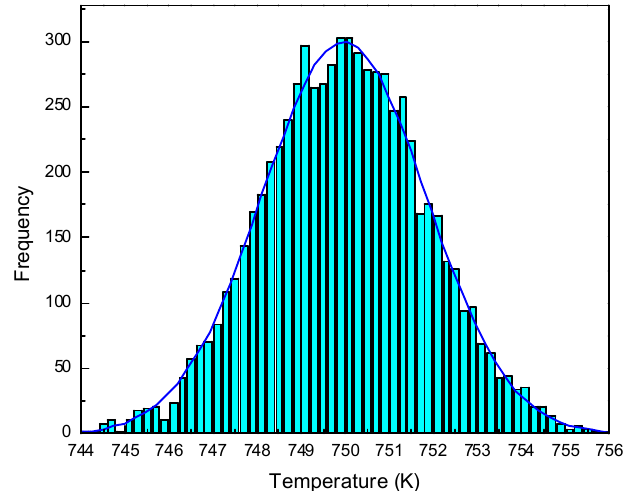
Figure 1. Frequency distribution of temperature for Cu held at 750 K fitted with the Gaussian function with R 2 > 0.99. The results were similar for all other cases.